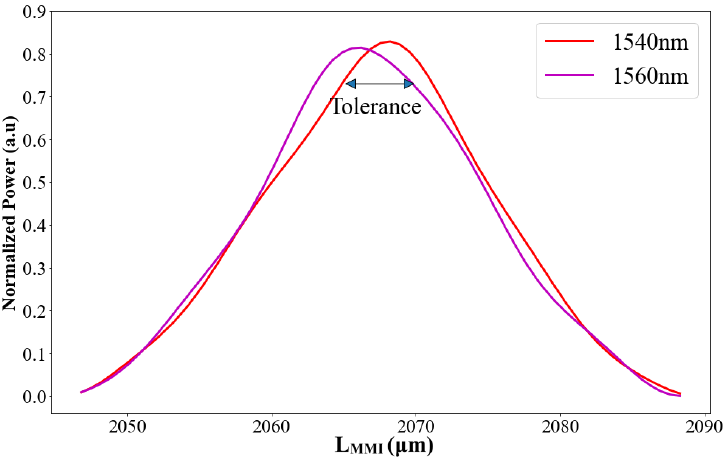
Figure 5. Normalized power as a function of MMI length.